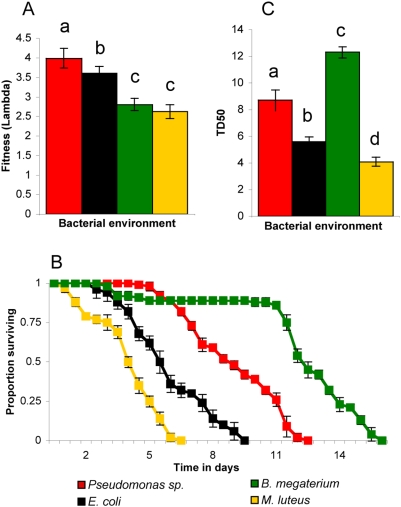
Effects of bacterial environment on wild-type life history traits.(A) Absolute fitness (λ) values for wild type (N2) in each bacterial environment. (B) Survivorship curves showing the proportion of the starting population surviving at different times in each bacterial environment. Letters over error bars indicate groups with significantly different means as determined by ANOVA. (C) Time to death for 50% of the individuals in a population (TD50) is shown for N2 grown in each bacterial environment. Standard error is indicated with error bars.